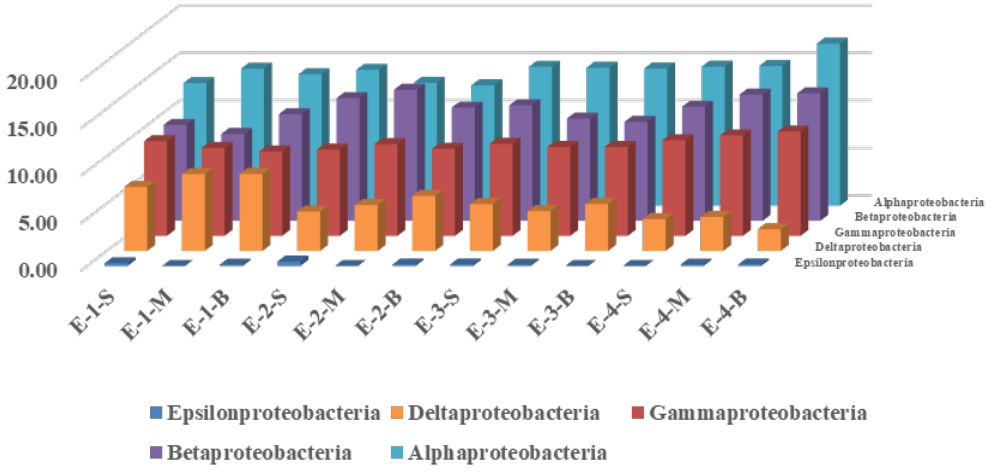
Figure 5. Changes in the proportions of Proteobacteria in the enhanced area during the operation of the water-lift aeration system. Labeling is consistent with that of Figure 4.